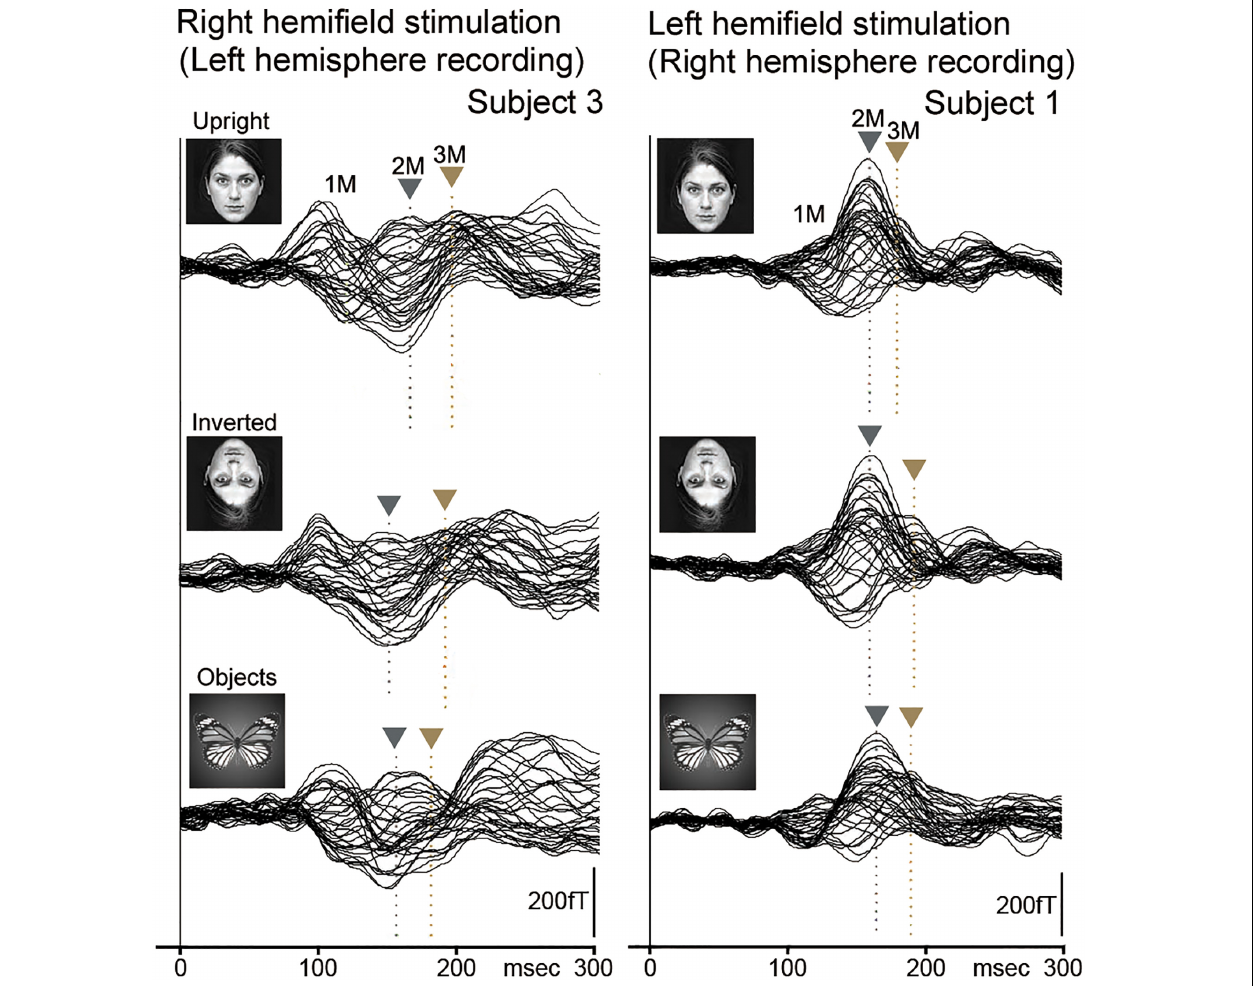
FIGURE 5 | The MEG waveforms for LHF and RHF stimulation in two representative subjects. MEG components (1M, 2M, and 3M) were clearly recorded in the right (LHF stimulation) and left hemispheres (RHF stimulation) in upright (upright face), inverted (inverted face), and objects (butterfly) conditions. The vertical gray and brown arrows indicate the peaks of 2M and 3M, respectively. In addition, the vertical gray and brown dotted lines indicate the peak latencies of 2M and 3M, respectively. 2M and 3M latencies for objects were not significantly different from those for faces (upright and inverted) [adopted from Watanabe et al. (2003)]. MEG, magnetoencephalography; LHF, left hemifield; RHF, right